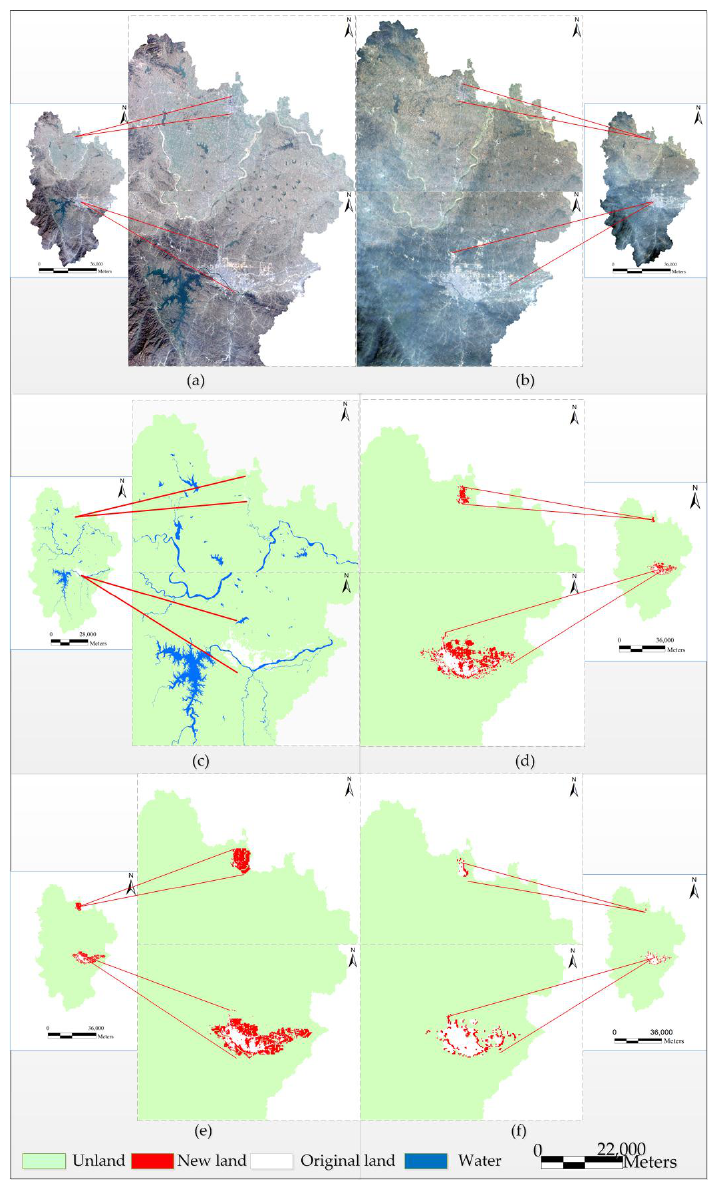
Figure 8. The map of the Xinyang urban construction land simulation forecast. The ( a ) represents Landsat image of Xinyang in 2008. The ( b ) represents Landsat image of Xinyang in 2014.The ( c ) represents original urban land of Xinyang in 2008. The ( d ) represents real result of urban construction land in 2014. The ( e ) represents simulation results of urban construction land in 2014. The ( f ) represents forecast of urban construction land use in 2020.